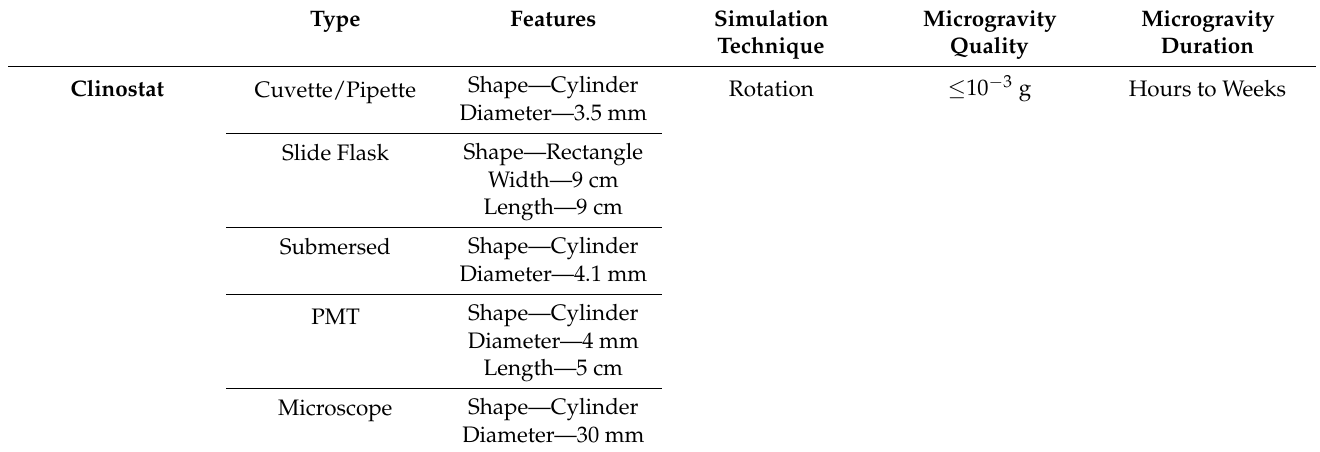
Table 1. Detailed information about laboratory-based microgravity